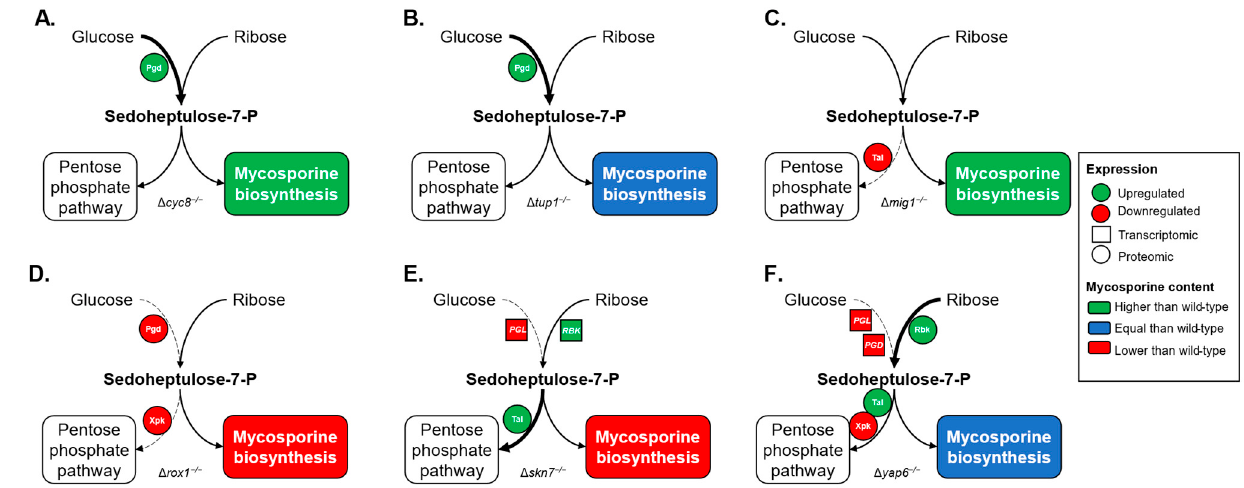
Figure 7. Effects of the CYC8 , TUP1 , MIG1 , ROX1 , SKN7, and YAP6 gene deletions in P. rhodozyma on the pentose phosphate pathway and their correlation with mycosporine biosynthesis. Differentially abundant proteins from proteomic studies and differentially expressed genes from transcriptomic studies were mapped to the pentose phosphate pathway, emphasizing effects on enzymes that may affect the availability of sedoheptulose-7-P for the production of mycosporines. The strains ∆ cyc8 − / − ( A ), ∆ tup1 − / − ( B ), ∆ mig1 − / − ( C ), ∆ rox1 − / − ( D ), ∆ skn7 − / − ( E ), and ∆ yap6 − / − ( F ) were grown on YNB-glucose minimal medium and compared to the wild-type strain. The proteomic data are represented by filled circles, and transcriptomic data are represented by filled squares. Thick and dashed arrows represent the proposed metabolic flux based on the expression profile. Enzymes, genes: 6-phosphogluconolactonase (Pgl, PGL ), 6-phosphogluconate dehydrogenase (Pgd, PGD